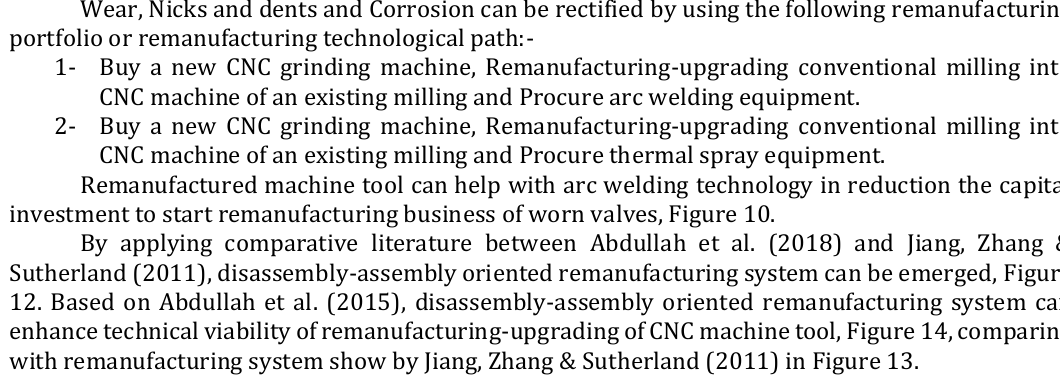
Figure 11: Benefit-Cost of CNC grinding-remanufactured milling-arc welding as a remanufacturing technology comparing with CNC Grinding-remanufactured milling- thermal spray